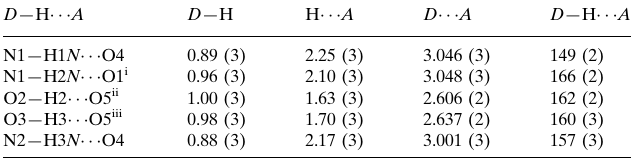
Hydrogen-bond geometry (A˚ , (cid:2)